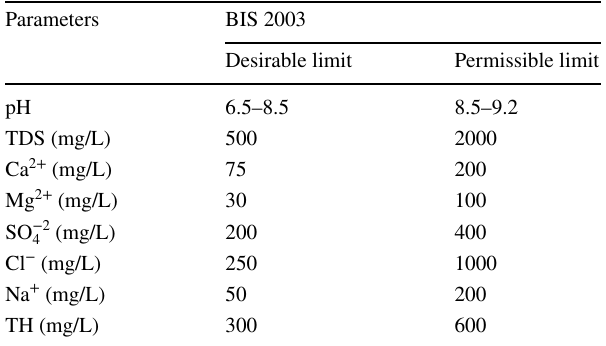
Table 4 Groundwater desirable and permissible limits prescribed by BIS for drinking